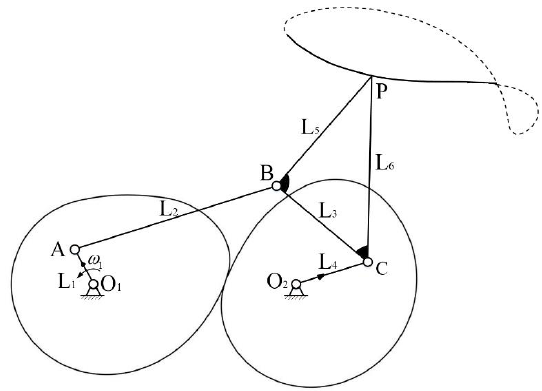
Figure 15. Diagram of noncircular gear-five-bar mechanism.